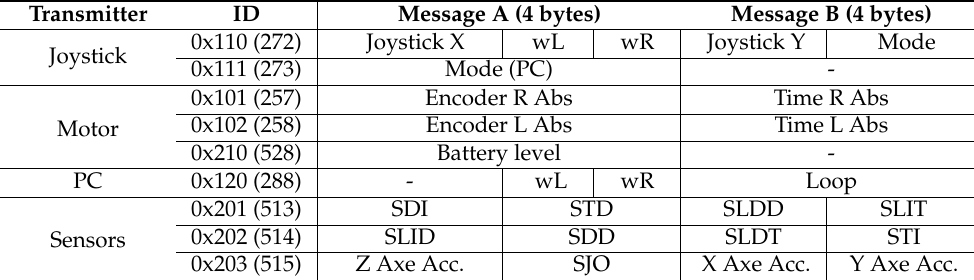
Table 1. Message structure of the CAN bus